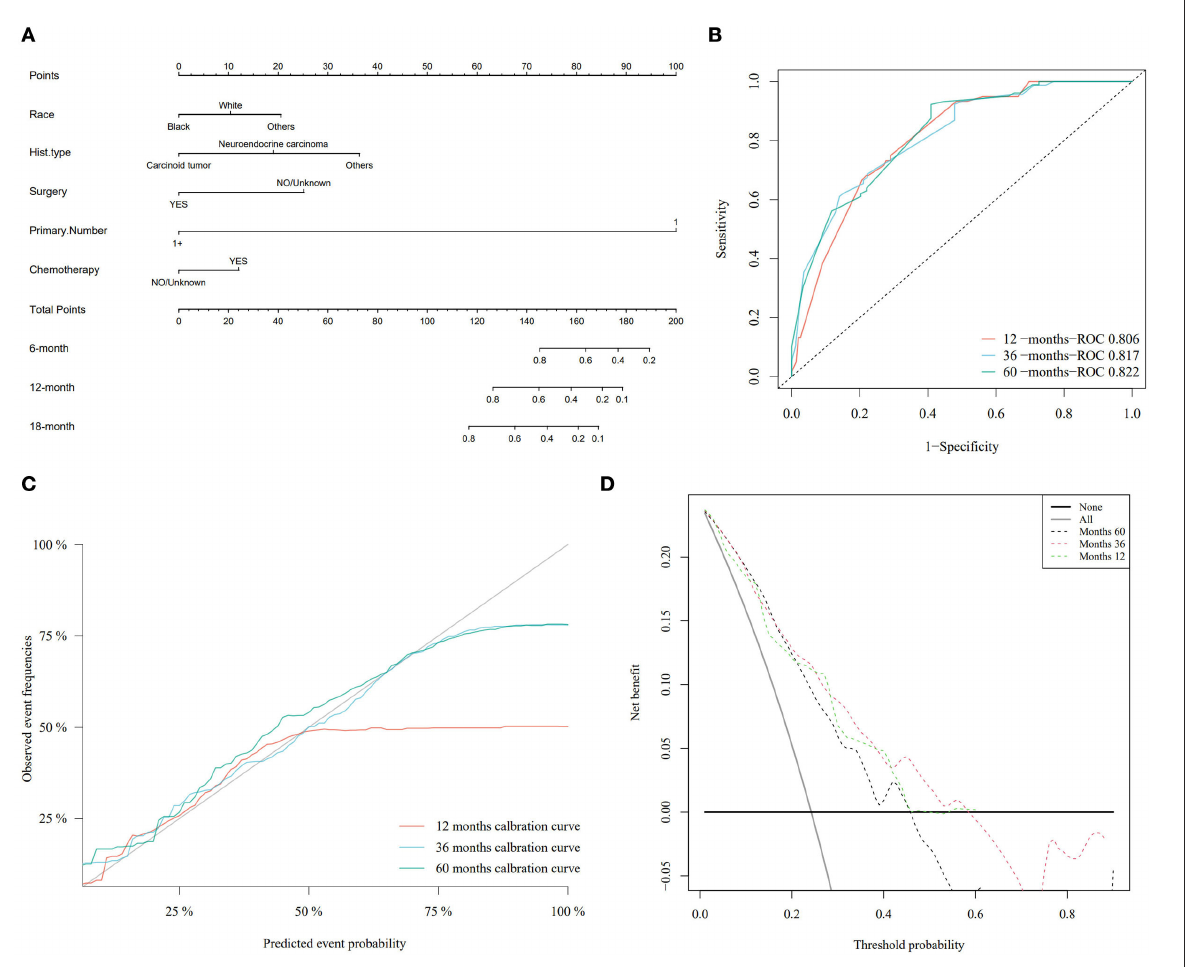
FIGURE4 Nomogram model and its performance based on Fine–Gray analysis of patients with primary hepatic neuroendocrine tumor (PHNET) in the training set. (A) Nomogram model; (B) receiver operating characteristic curve; (C) calibration curves; and (D) decision curve analysis.